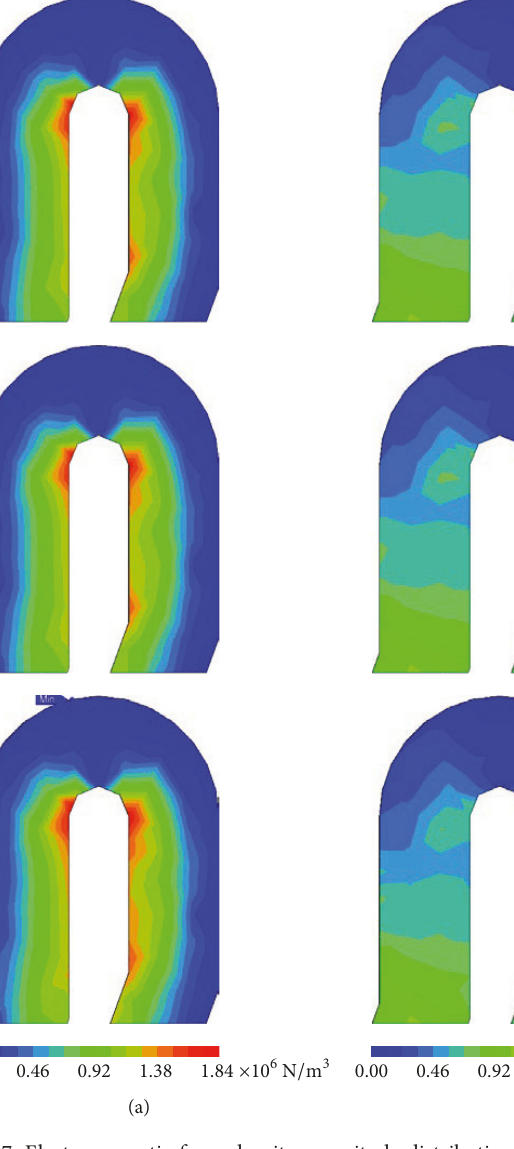
Figure 17: Electromagnetic force density magnitude distribution on the nose part at 0.039 s, when 𝑙 (middle), and 𝑙 = 421 mm (top). (a) Radial component. (b) Tangential component. (c) Axial sc